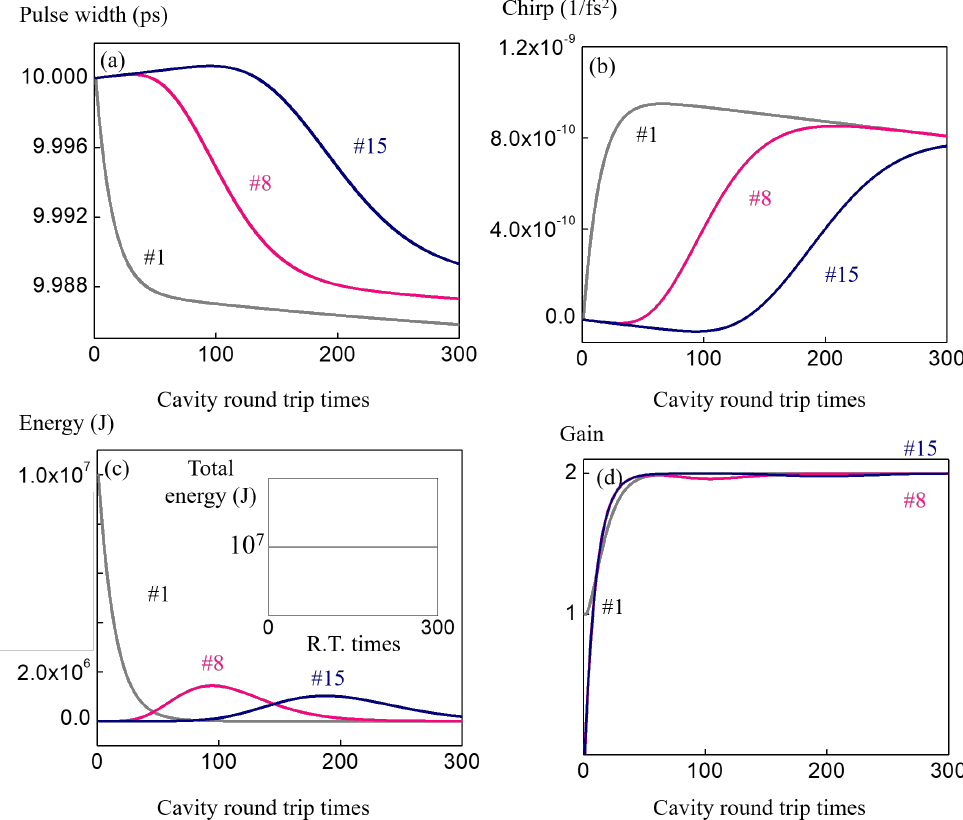
Figure 5. For clarity, only pulses index number 1 (first pulse, in gray), 8 (central pulse, in red), and 15 (last pulse, in blue) are plotted, where distinct behaviors can be observed from ( a ) pulse widths, ( b ) chirps, ( c ) energies, and ( d ) gain. In ( a , b ), the energy differences cause the balance (gray) or imbalances (red and blue) between the self phase modulation and the dispersion, which results in pulse widths change and differences in the sign of the chirp coefficients. Panel ( c ) shows the energy exchange from the three pulses. Due to the direction of coupling, the energy of the first pulse drops and the central and the last pulses grow. A more complete picture of energy trading can be seen from Figure 5. When the pulse bunch is well developed into a symmetric, constant shape, the gain and loss are balanced for every pulses, as shown in the panel ( d